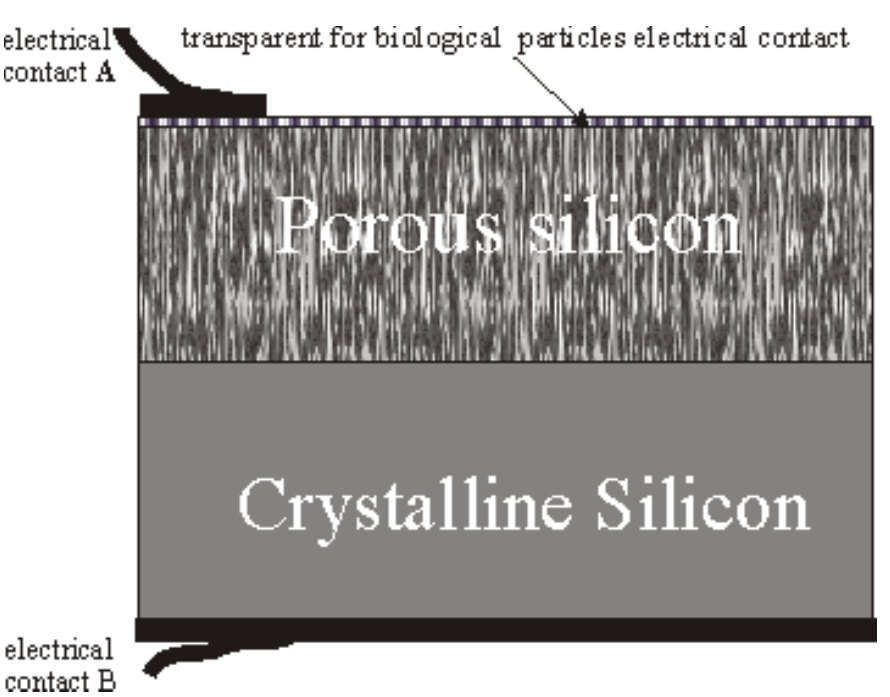
Figure 1. Cross-sectional view of the microelectronic devices with electric contacts A and B on the base of the mesoporous silicon formed from crystal